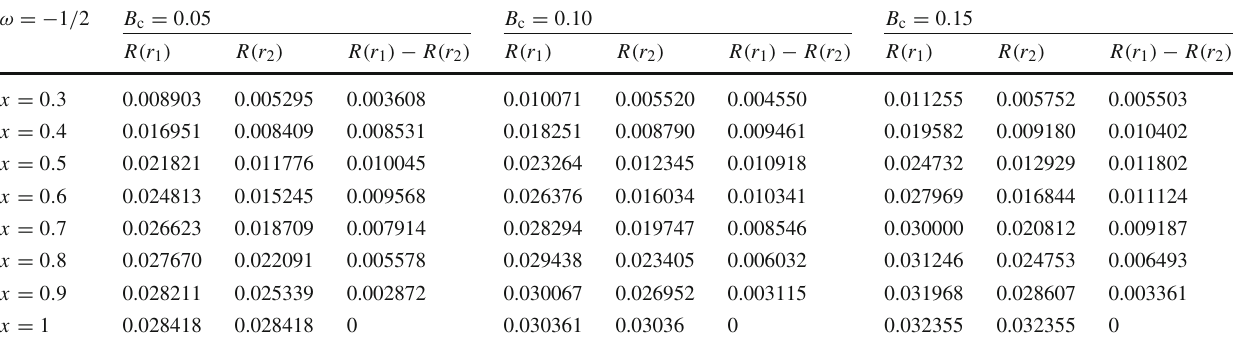
Table 4 The Ruppeiner curvature scalar for differential B c with ω = − 1 /